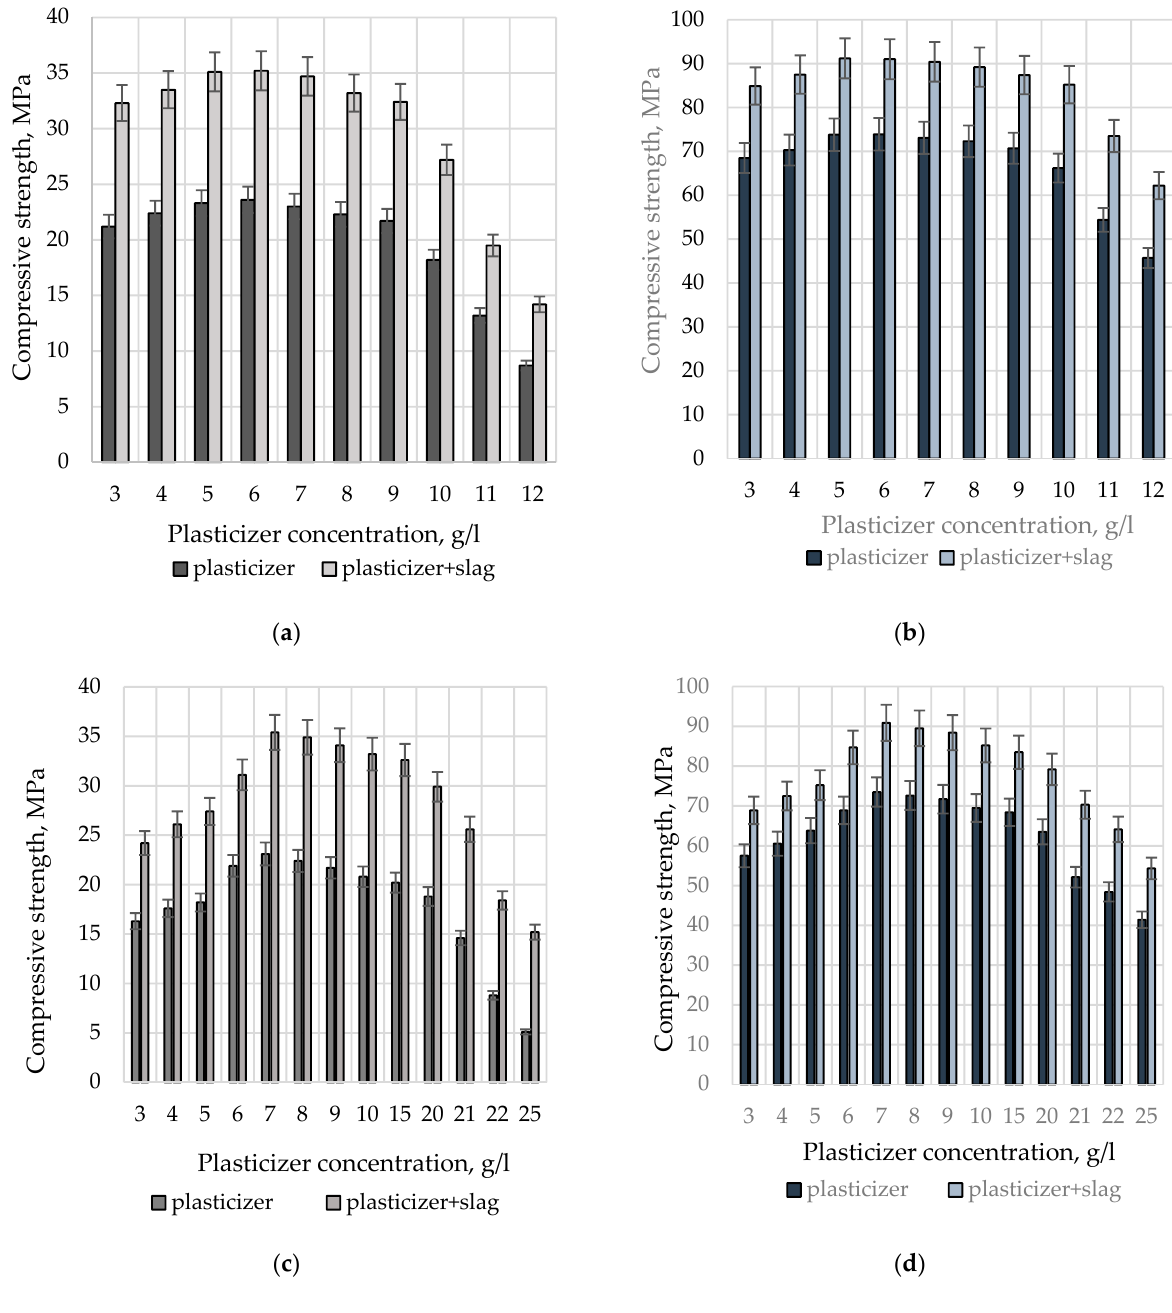
Figure 20. The dependence of the strength of the samples on the concentration of the plasticizer: ( a , b )—soft water (No. 1); ( c , d )—hard water (No.2); ( a , c )—at 1 day of hardening; ( b , d )—at 28 days of hardening.